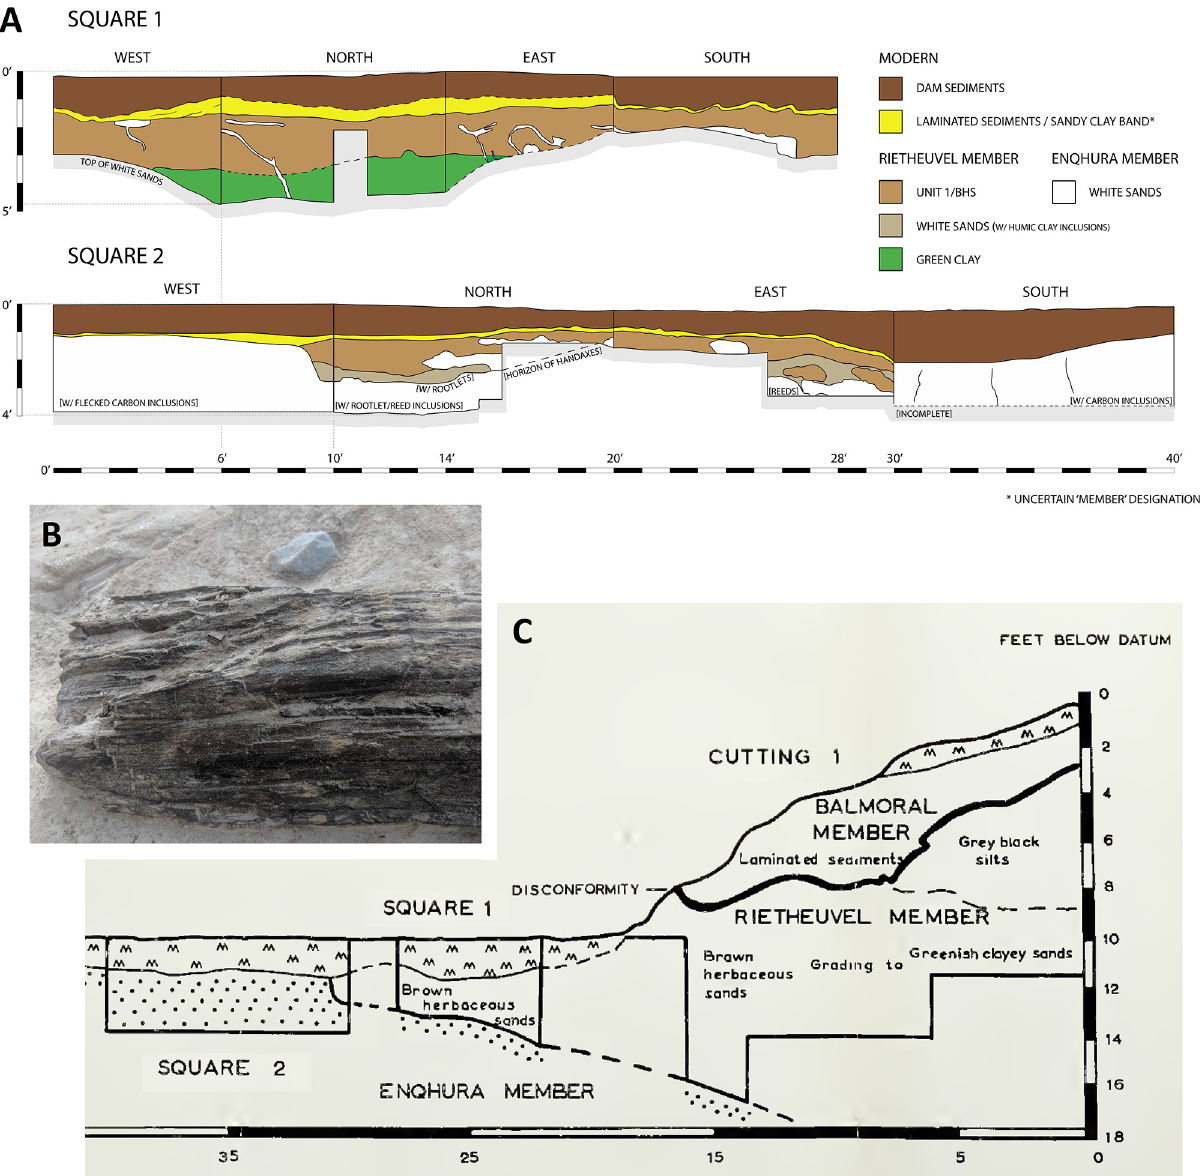
Fig 19. Stratigraphy of Area 1 Square 1 and 2 based on (A) Deacon’s redrawn excavation notes; (B) Wood and associated Acheulian artefacts from our 2019 excavations adjacent to Square 2 (C) Deacon’s [10] stratigraphic sections of Square 1 and 2.